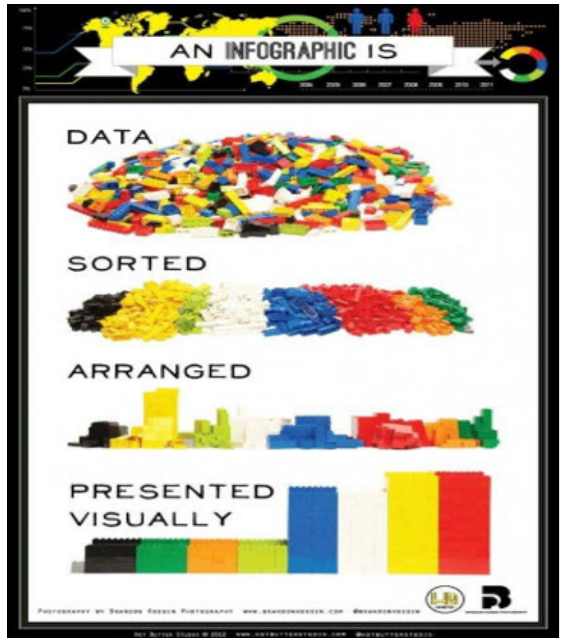
Figure 2. What is an infographic? Re - trieved from: https://visual.ly/community/in - fographic/how/what-infographic Furthermore, Kibar and